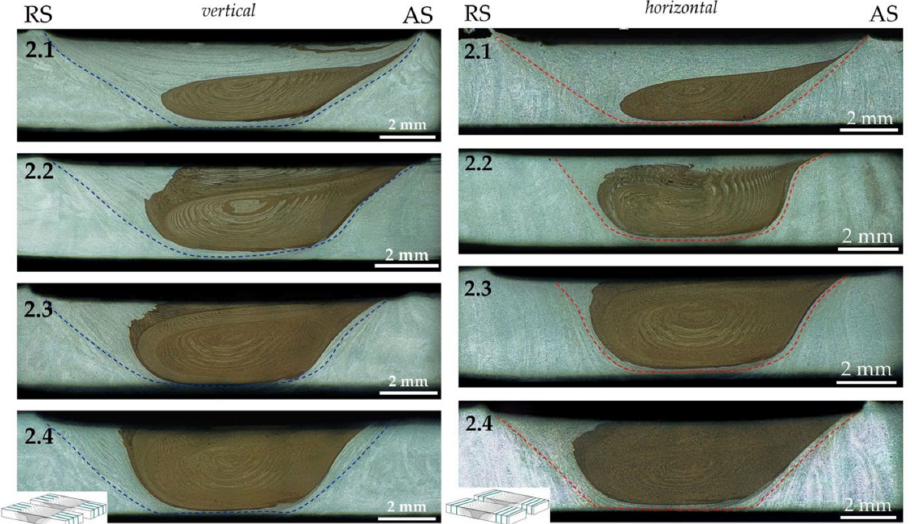
Figure 17. Macrostructure of samples made by electron beam additive technology from AA5056 alloy after FSP in vertical and horizontal direction by modes 2.1–2.4. RS—retreating side, AS—advancing side, blue and red dashed lines indicate the stir zone boundaries [177].